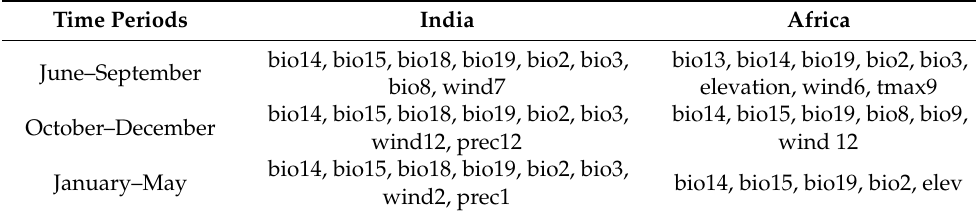
Table 2. Environmental variables selected after the correlation test. Time Periods